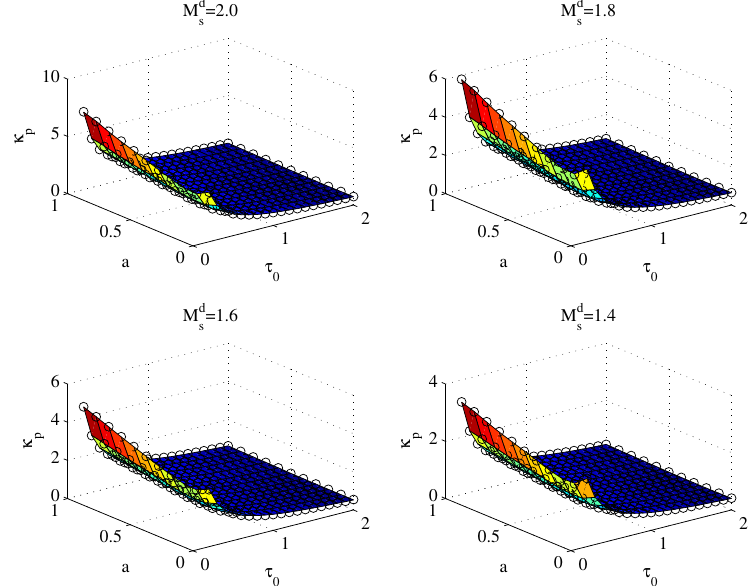
Figure 5. Calculated and approximated optimal κ p in the regulation mode.